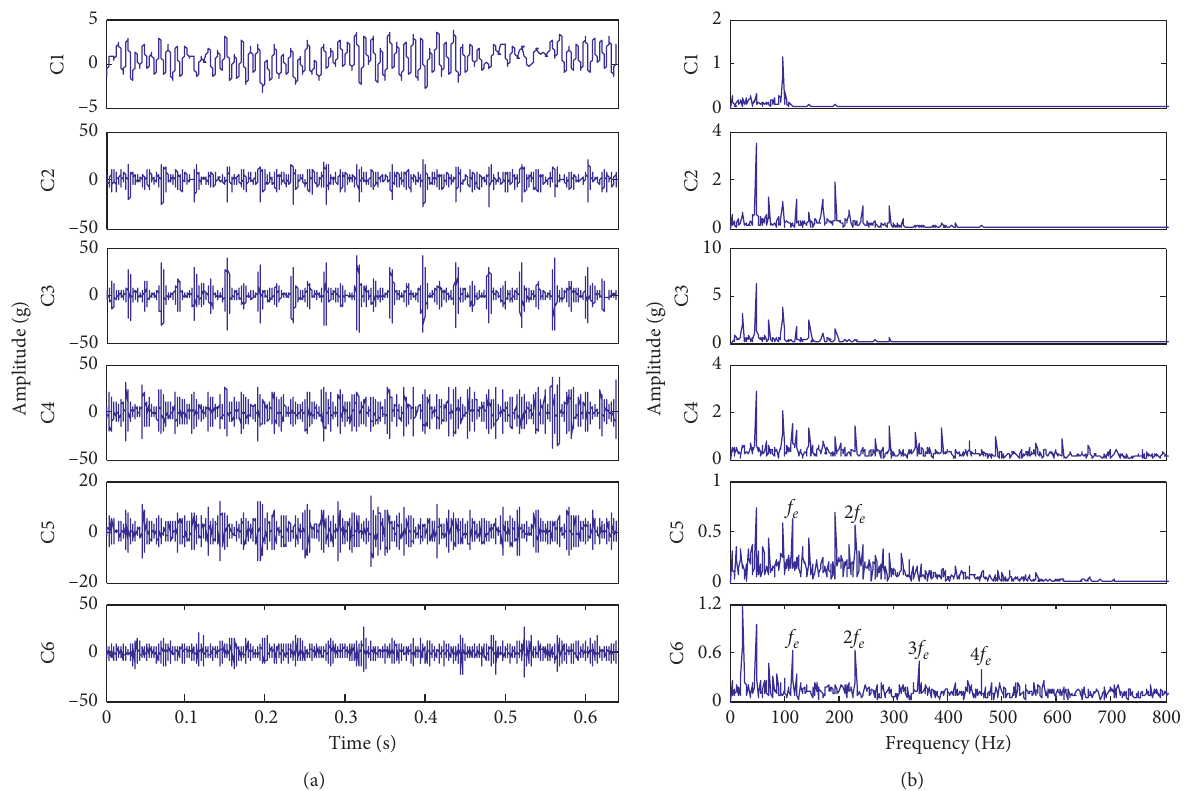
Figure 17: Comparison results of experimental signal by the EWT method: (a) the waveforms of separated components; (b) the envelope spectra of separated components.